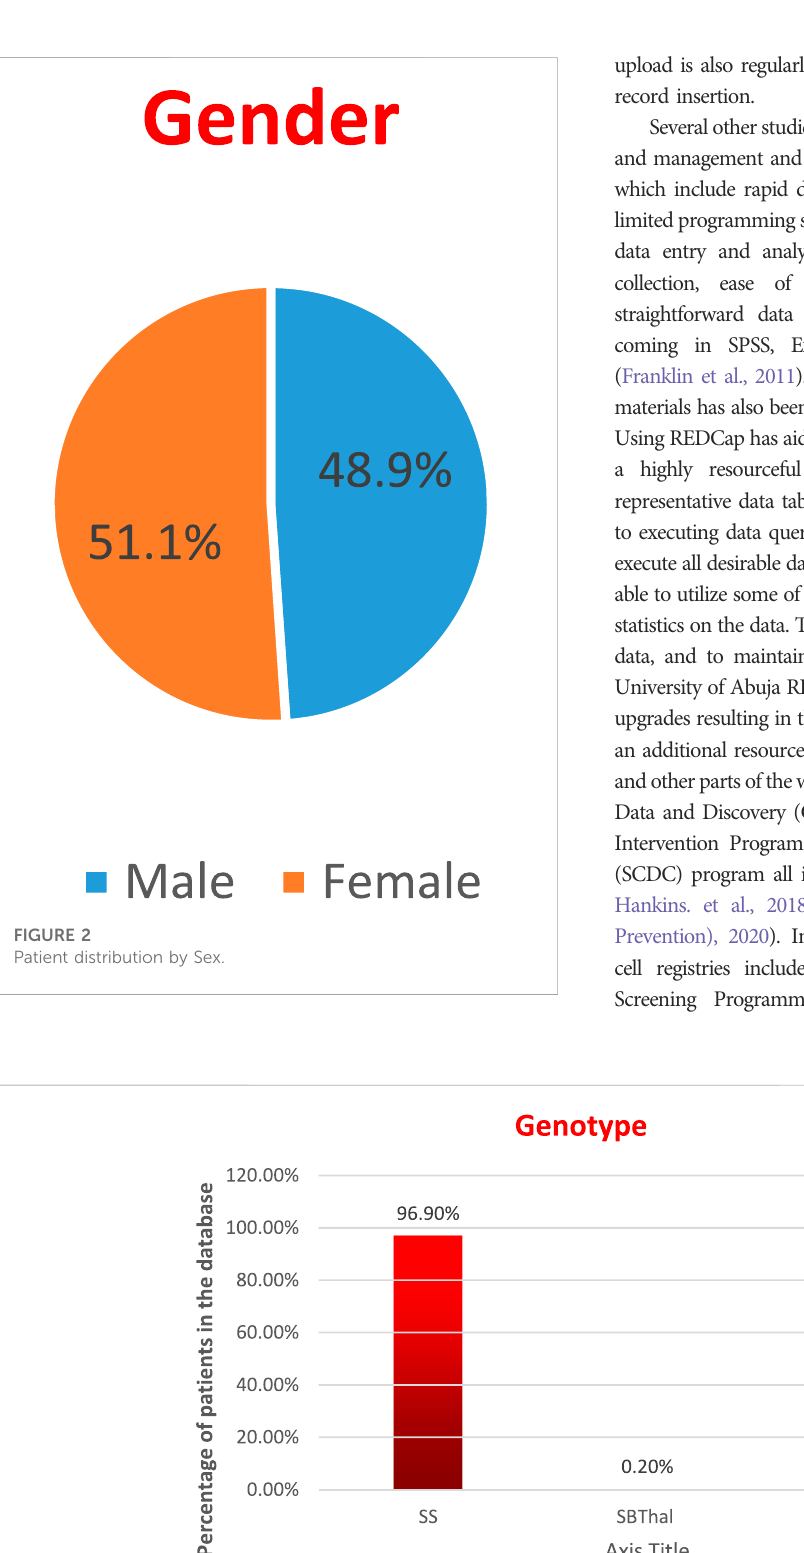
FIGURE 3 Distribution of patients by